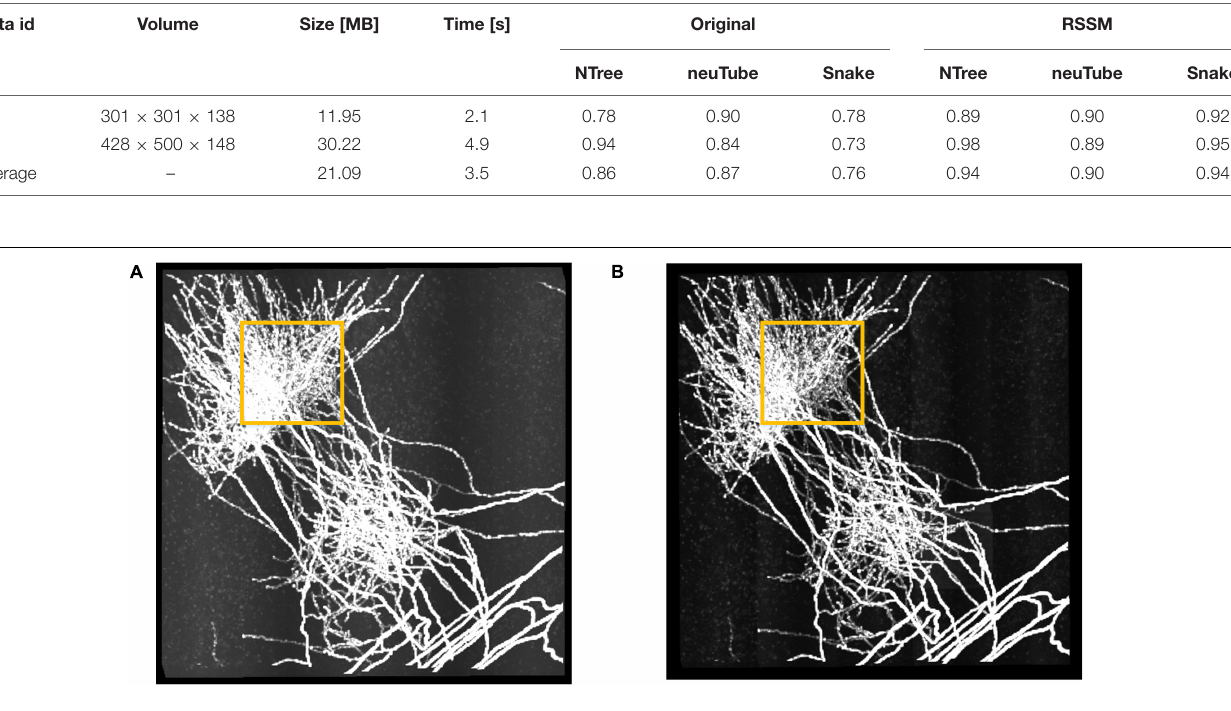
FIGURE 6 | The performance of RSSM on a large neuronal dataset. (A) Shows a fMOST neuronal dataset with size 2,560 × 2,560 × 512 ( ∼ 6.4 GB). (B) Shows the corresponding estimated foreground by RSSM. Some haze noises in the marked region (yellow) was suppressed by RSSM, and the visualization of the estimated foreground was